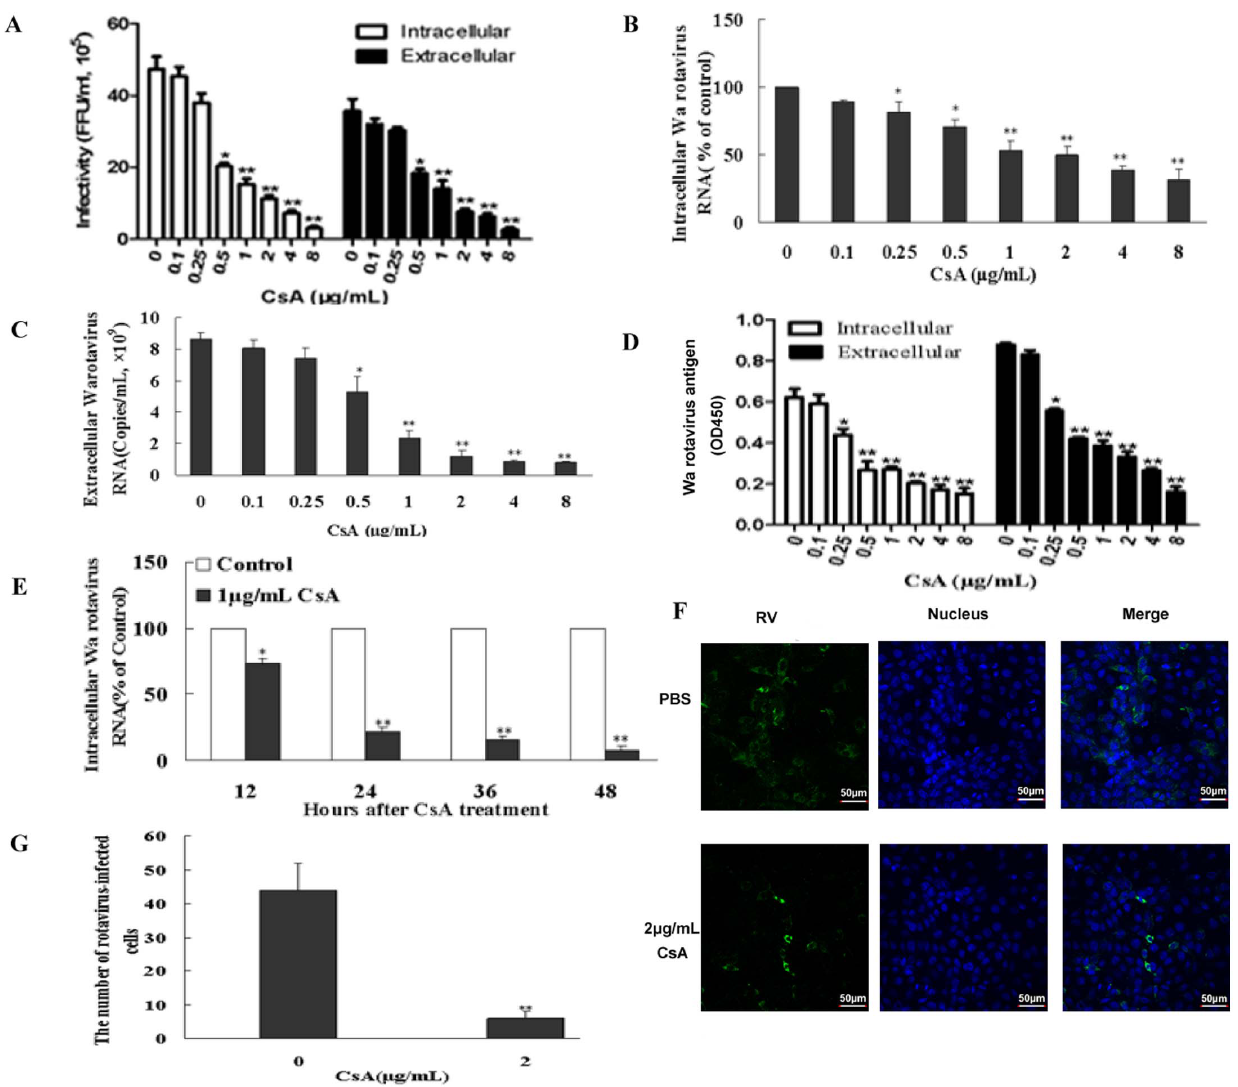
Figure 1. Effect of cyclosporin A (CsA) on Wa rotavirus replication invitro . Infectious viral titers (A) were determined by serial dilution and immunofluorescence analysis. The intracellular or extracellular Wa rotavirus is expressed as focus-forming units per milliliter (FFU/mL) of cell lysate or supernatant, respectively. Wa rotavirus RNA expression levels (B) were determined by qRT-PCR. The levels of intracellular Wa rotavirus RNA are expressed as % of control (without CsA treatment, which is defined as 100) normalized to glyceraldehyde-3-phosphate dehydrogenase (GAPDH) mRNA. The levels of extracellular Wa rotavirus RNA (C) are expressed as viral copies/mL. Wa rotavirus antigen (D) levels were determined by ELISA. The intracellular or extracellular Wa rotavirus antigen is expressed as OD450. (E) Time-course effect of CsA on Wa rotavirus replication. Intracellular RNA levels, normalized to GAPDH mRNA, are expressed as % of control (without CsA treatment, which is defined as 100). (F) Immunofluorescent evaluation of rotavirus infection in HT29 cells was carried out by direct immunofluorescence staining with goat anti-rotavirus immunofluorescence antibody (green). (G) Histogram of immunofluorescence results. One representative experiment is illustrated (magnification: 200 6 ). The results (A-G) shown are expressed as mean 6 standard deviation of triplicate cultures, and 3 independent experiments were carried out (* P , 0.05, ** P ,